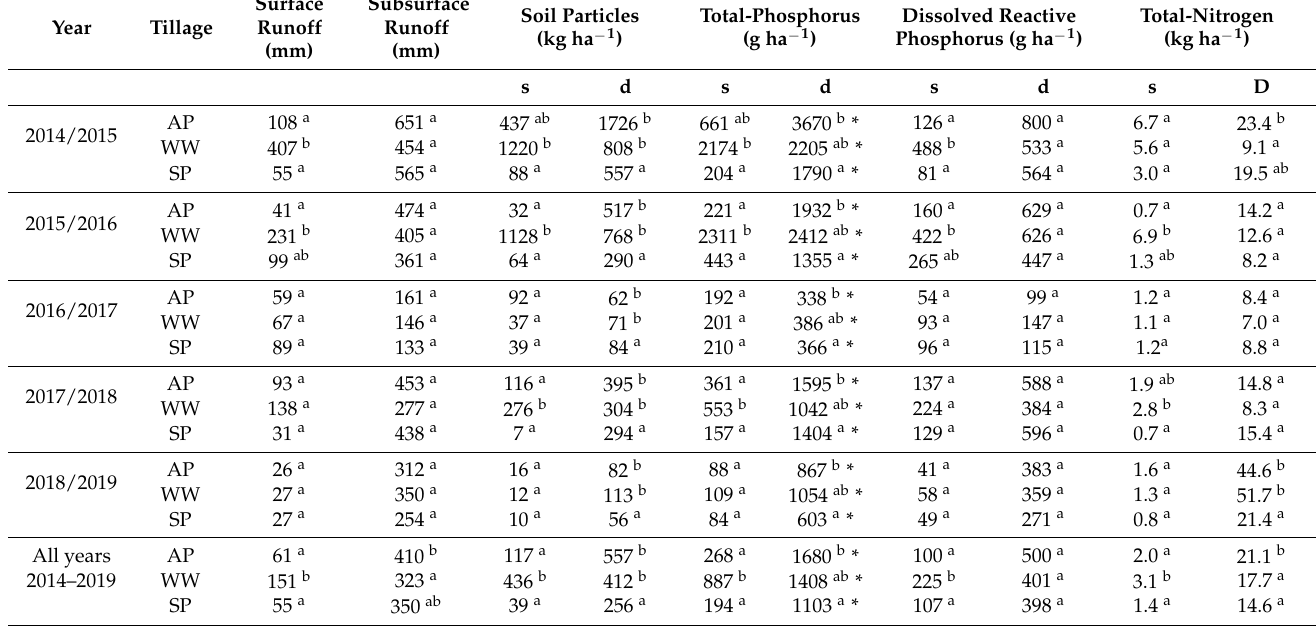
Table 6. Average annual runoff and losses of soil, total phosphorus, dissolved reactive phosphorus and total nitrogen through surface (s) and subsurface (d) runoff for autumn ploughed (AP), winter wheat (WW) and spring ploughed (SP)